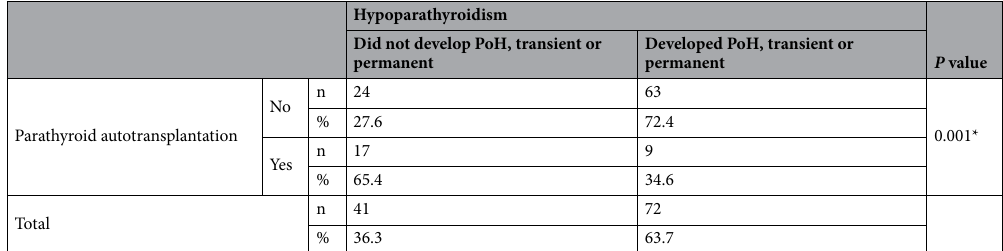
Hypoparathyroidism